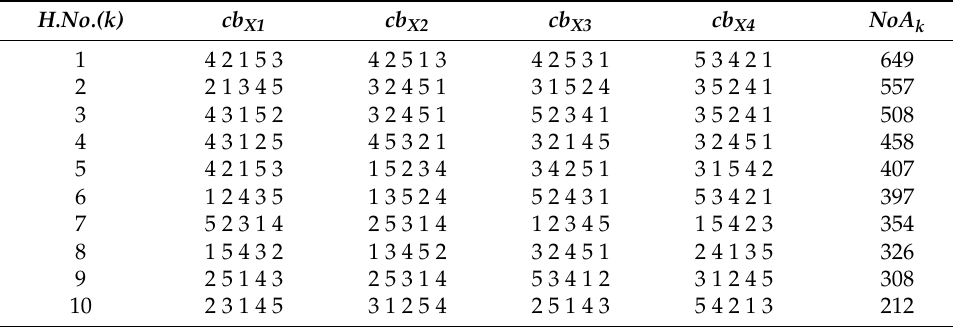
Table 7. Harmonies after sorting based on